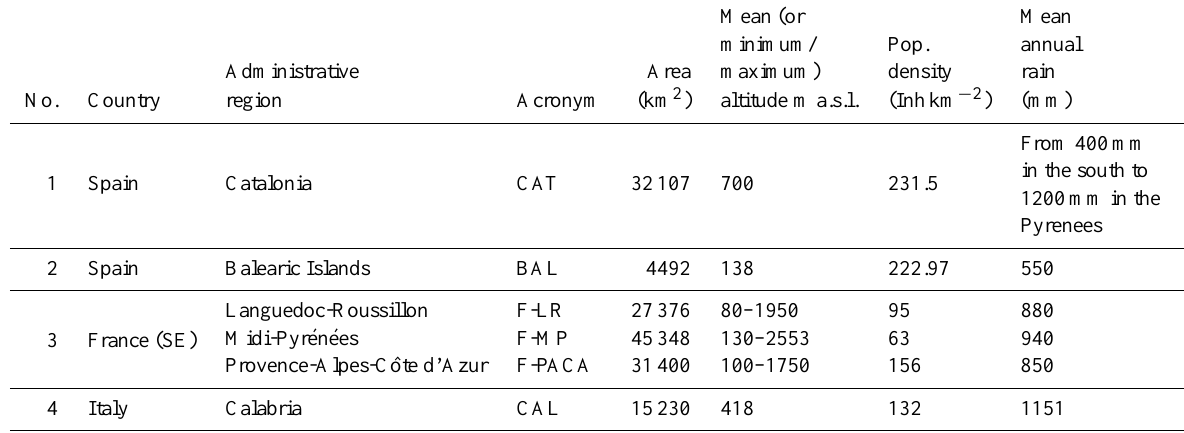
Table 1. Main features of the selected